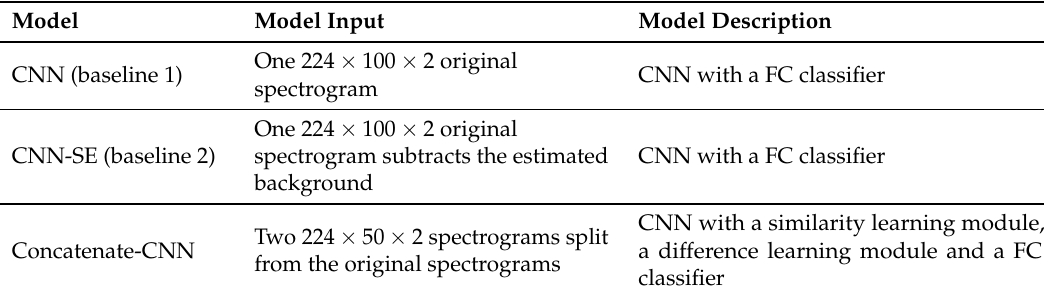
Table 3. Model input and